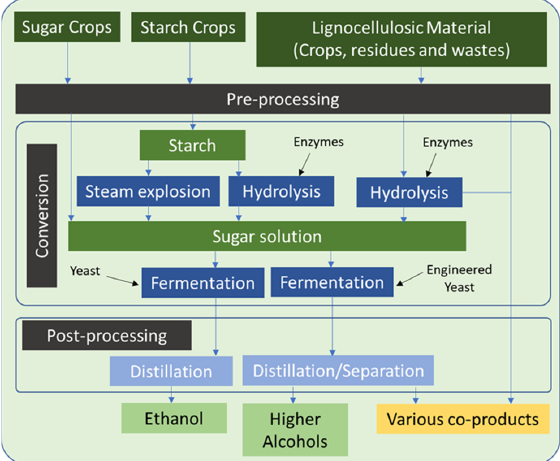
Figure 8. EVC1—Sugar to alcohols. Adapted from [26].